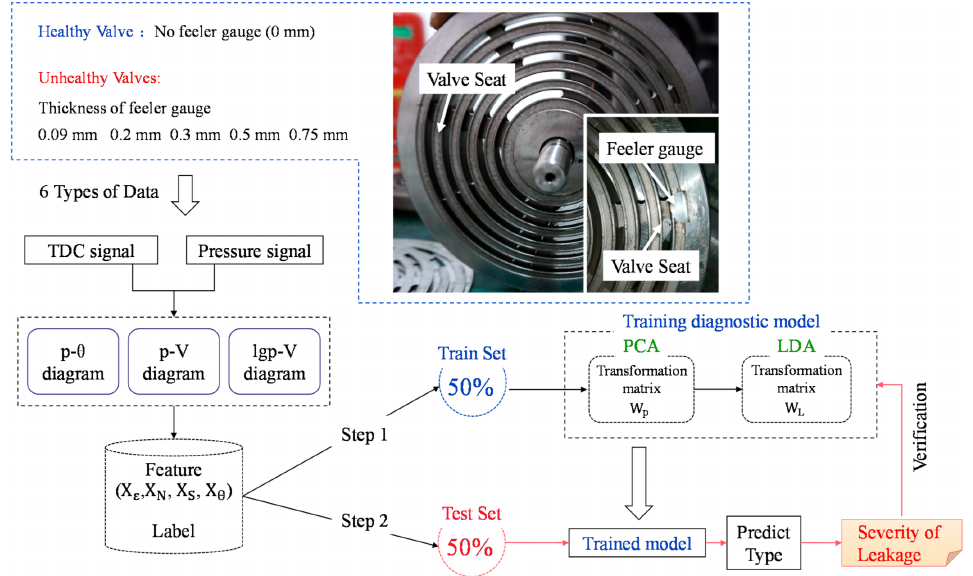
Figure 7. Flow chart of diagnosis and severity estimation